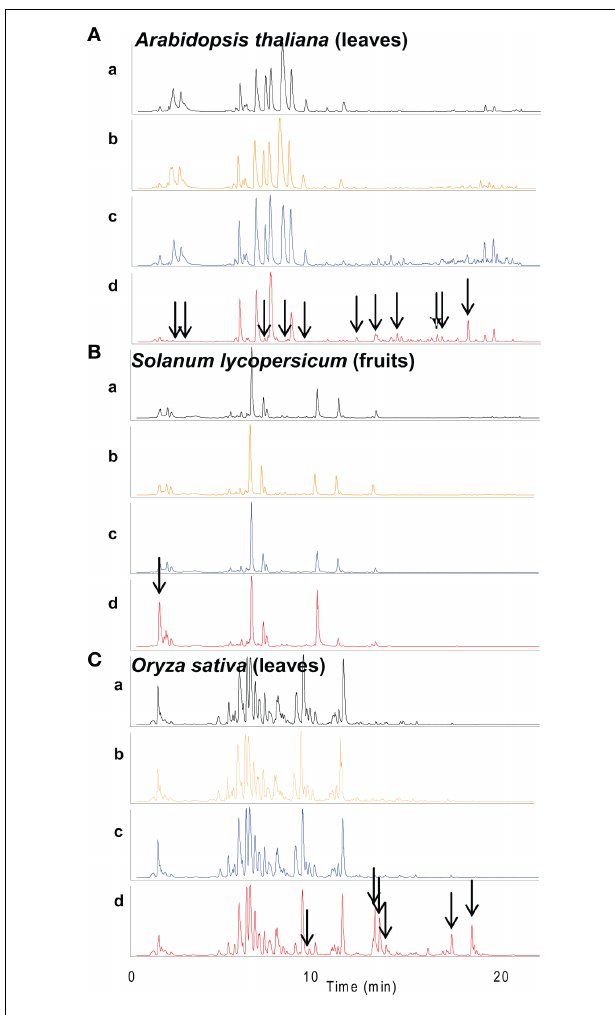
FIGURE 2 | Effect of different extraction methods on secondary metabolite breakdown in Arabidopsis leaves, tomato fruits, and rice leaves. Total ion chromatograms (TIC) monitored by negative ion detection mode of extracts of (A) Arabidopsis leaves, (B) tomato fruits, and (C) rice leaves, are shown. (a–d) indicate different extraction methods. (a) extraction method as described inTohge and Fernie (2010), (b) extracts obtained by (a) method were incubated at 37˚C for 1h, (c) extraction buffer was immediately added to frozen material on ice, (d) frozen sample was incubated at 37˚C for 1h before extraction. All extractions were performed using pre-cooled extraction buffer (10˚C). Arrows show peaks which were newly or not detected in treated